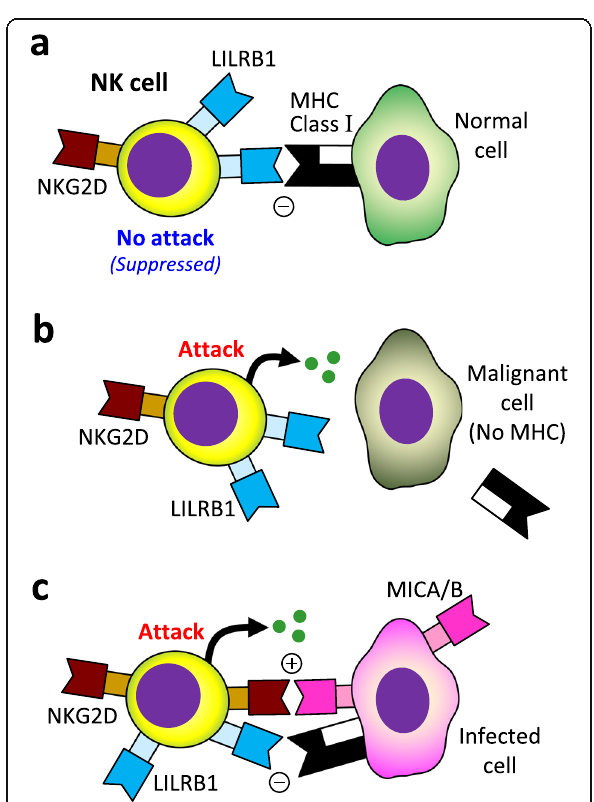
Fig. 4 Recognition of normal ( a ), malignant ( b ), and infected cells ( c ) by NK